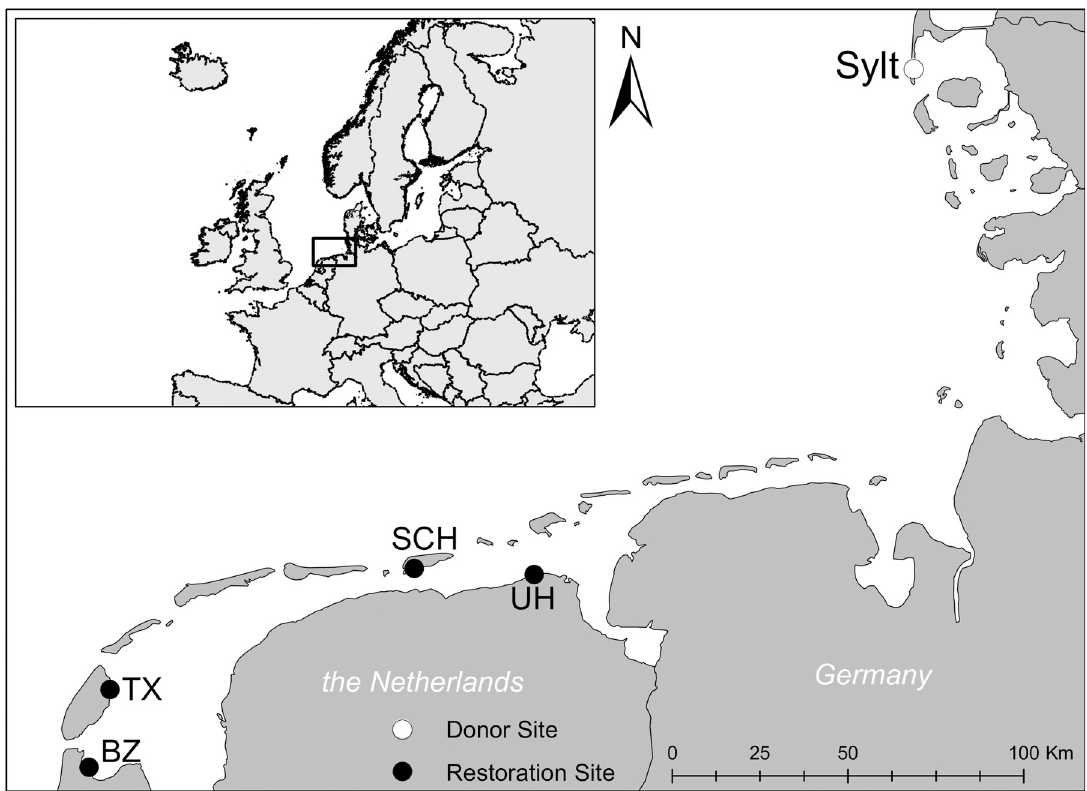
Fig 1. Location maps. (A) Location of restoration sites and donor site in North Western Europe, (B) Locations of restoration sites (black dots) and donor site (Sylt, white dot) in the Dutch Wadden Sea. Abbreviations of donor sites stand for: BZ = Balgzand, TX =